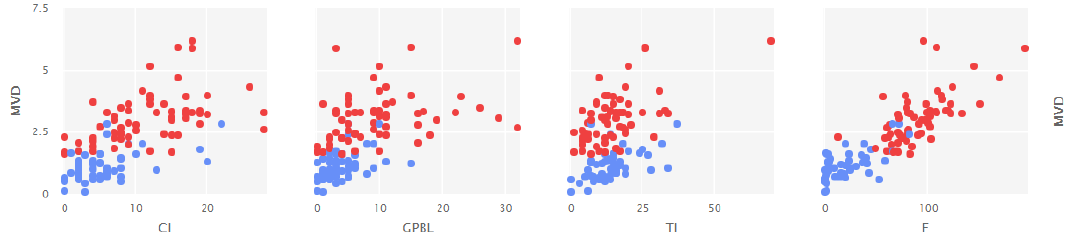
Figure 2. Distribution of scores in the different types of behavioral learning in the LMS. Note. CI = Access to Complementary Information scores; CPBL = Access to guidance to prepare PBL scores; TI = Access to Theoretical Information scores; F = Access to Teacher Feedback; MVD = Mean Visits per day.